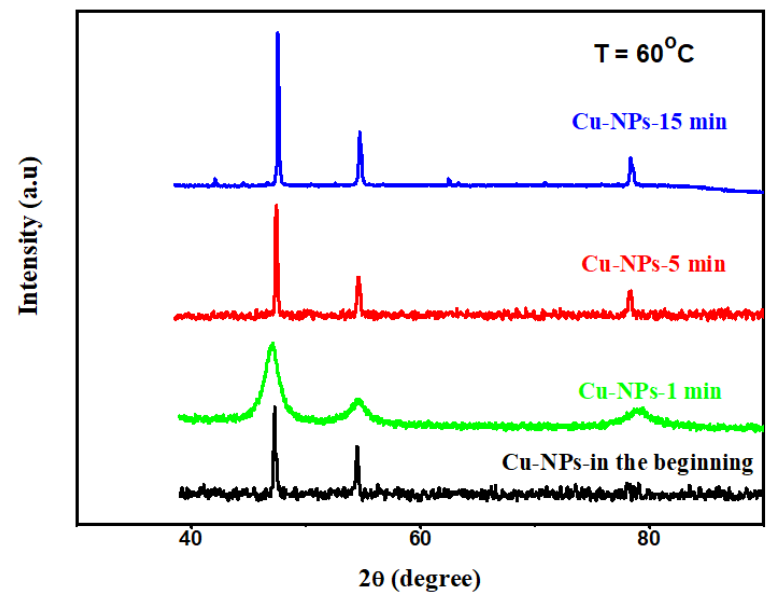
Figure 5. X-ray diffraction patterns of small sized Cu-NPs after staying at 60 °C for different